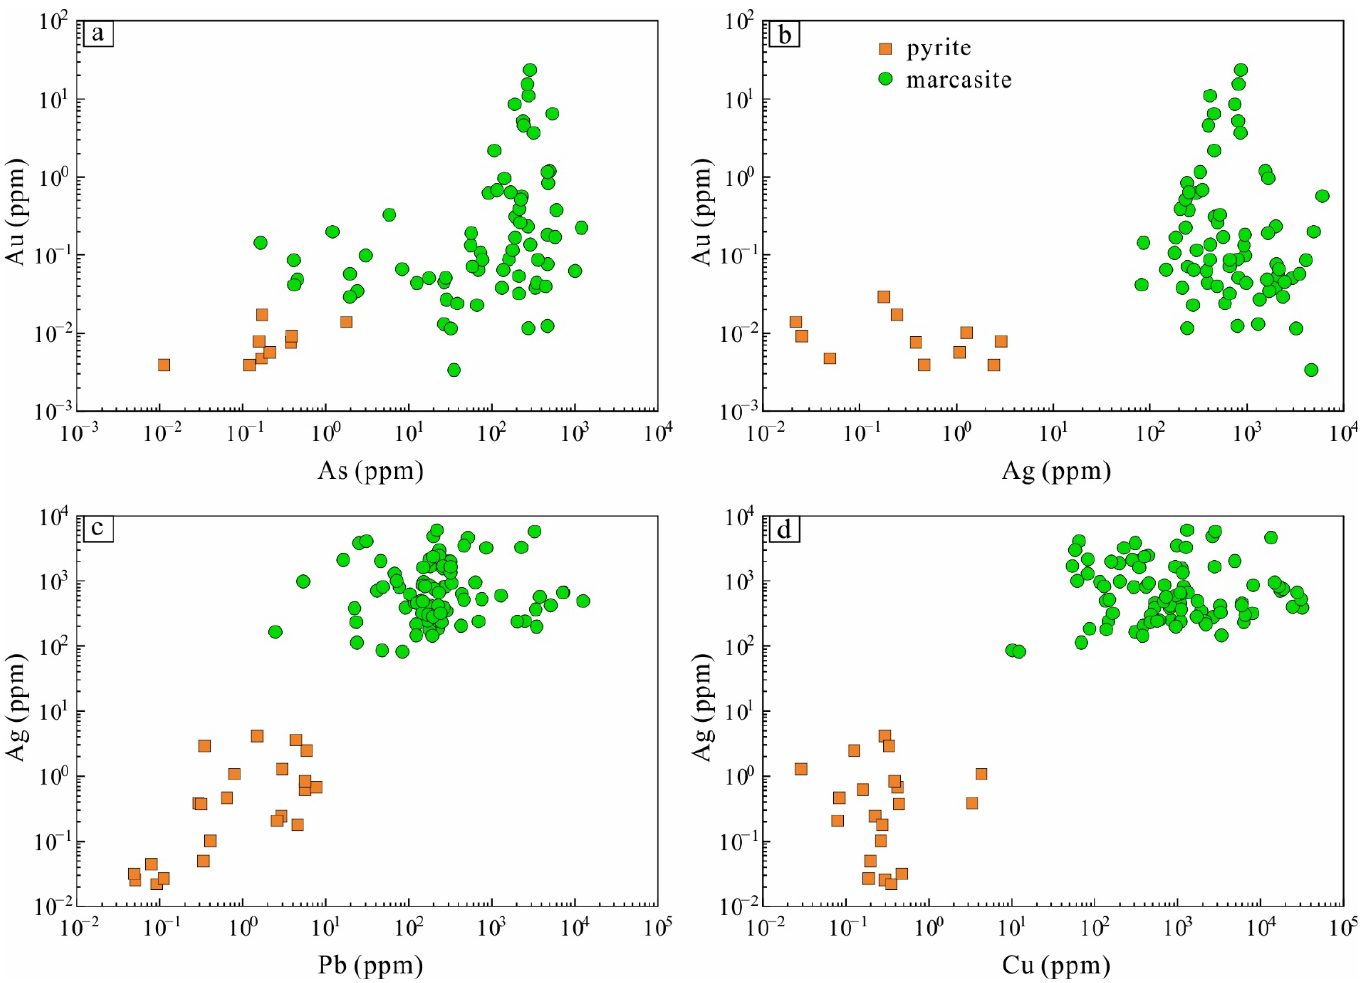
Figure 8. Binary plots of Au vs. As ( a ), Au vs. Ag ( b ), Ag vs. Pb ( c ), and Ag vs. Cu ( d ) in pyrite and